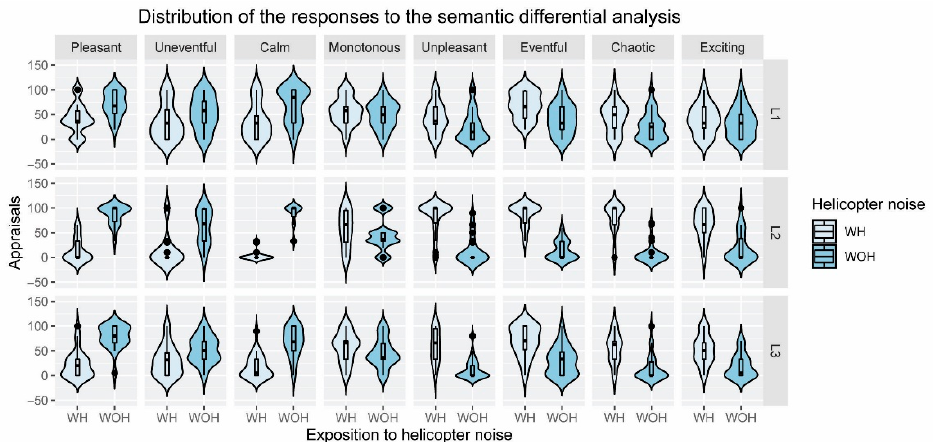
Figure 4. Distribution of the responses to the semantic differential analysis (pleasant, uneventful, calm, monotonous, unpleasant, eventful, chaotic, and exciting) with (WH) and without (WOH) the helicopter noise, split by location (L1, L2, and